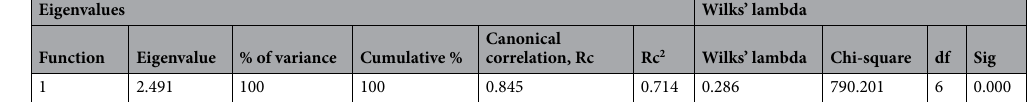
Canonical correlation, Rc Rc